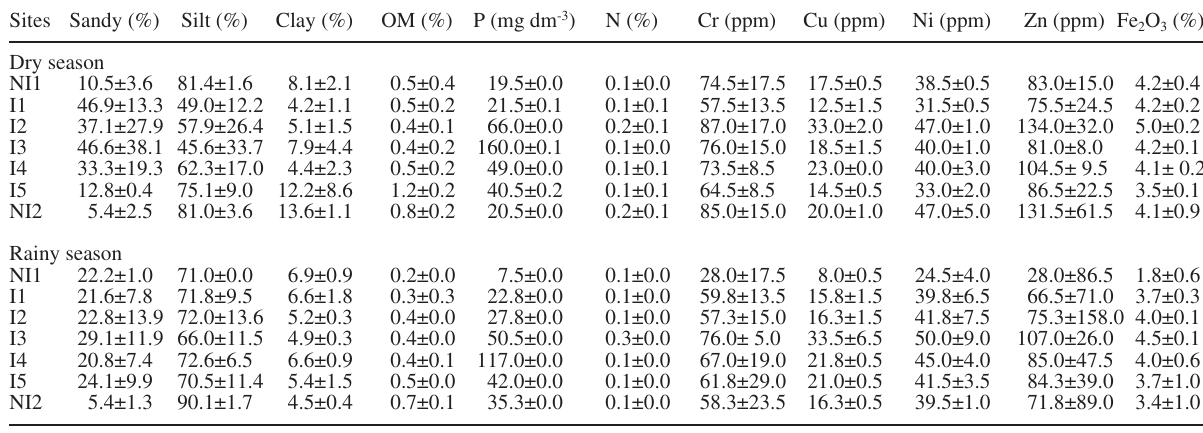
Table 2. – Sediment chemical characteristics. Values (mean±SE) are shown for each sampling season. I, impacted sites; NI, non-impacted sites. OM, organic matter. Sites Sandy (%) Silt (%)